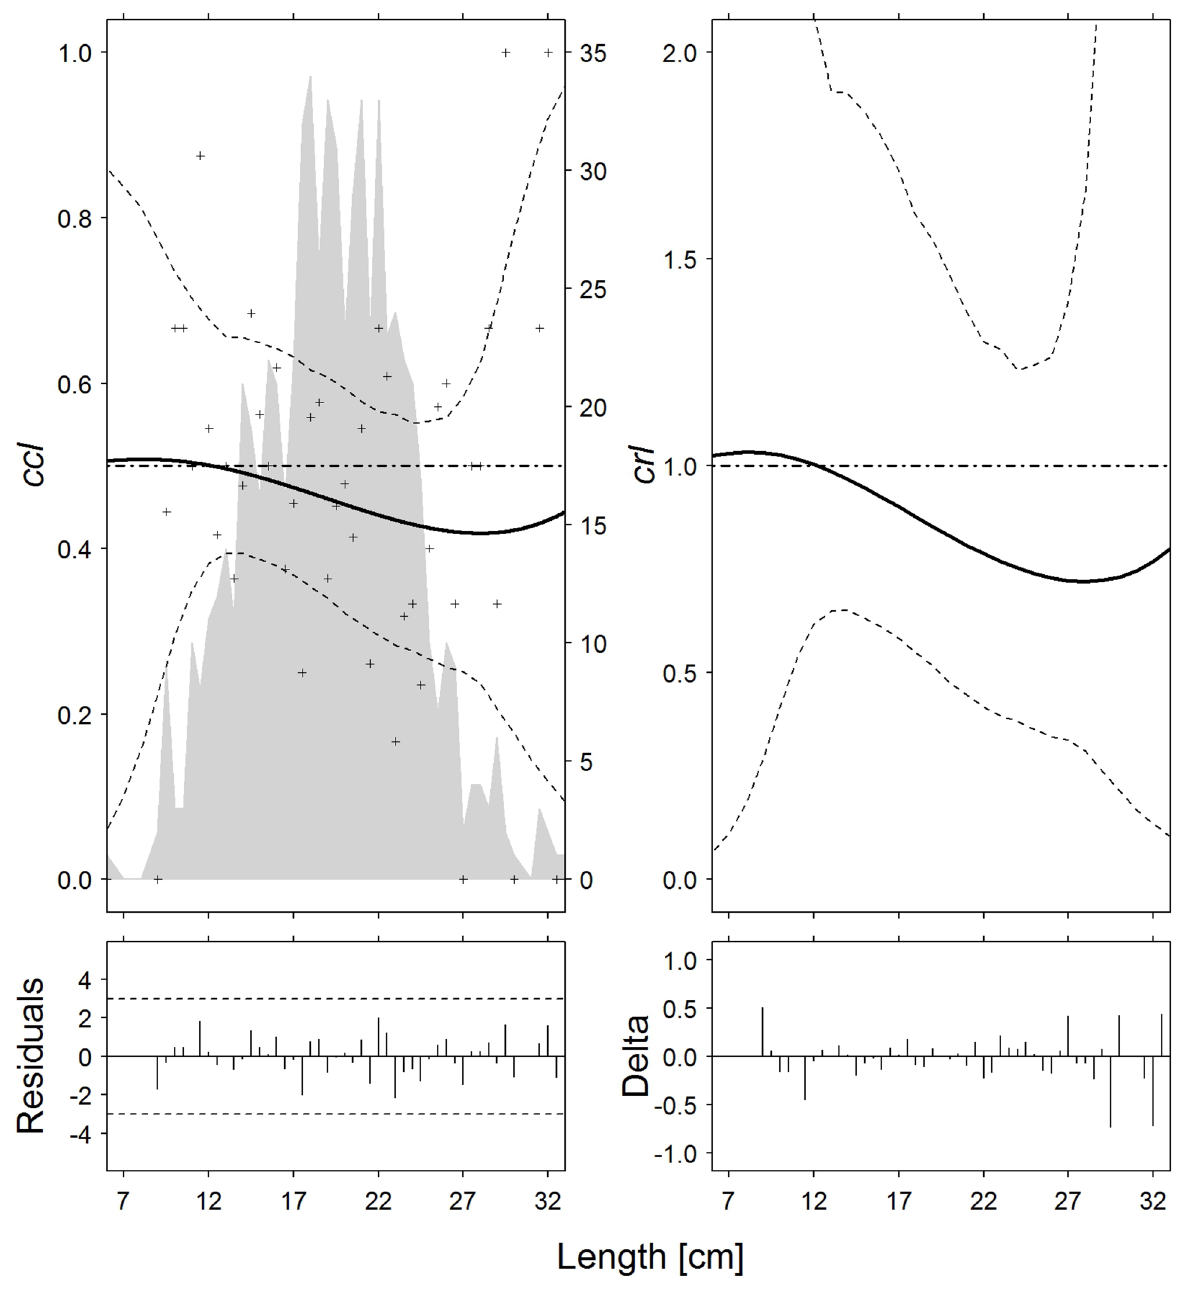
Fig 1. European hake ( M . merluccius ). Catch comparison rates ( cc 60-minute tows (solid curves). Crosses: experimental rates; thin dotted curves: 95% confidence intervals; grey solid curve: summed and raised catch populations for all hauls; horizontal dashed line: baseline of no effect on catch performance after changing tow duration. Partial residual plots ( bottom left ) and delta dispersion ( bottom right ) for the two models.